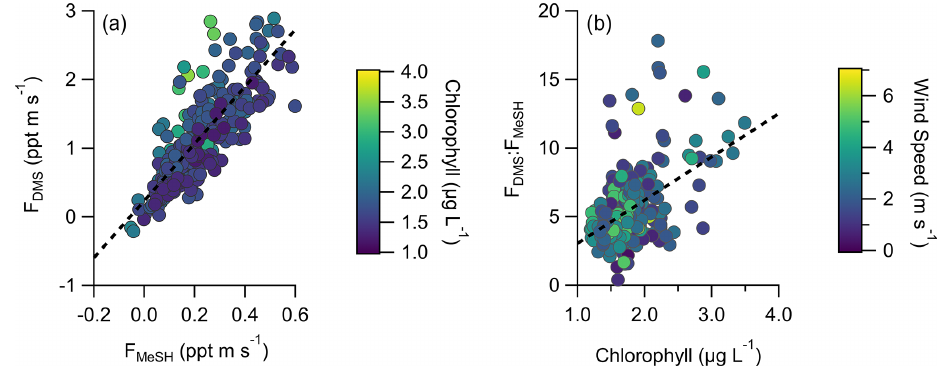
Figure 6. (a) Correlation and linear least squares regressions of measured MeSH and DMS emission fluxes ( F MeSH and F DMS , respectively). The slope of the best fit line is 4.15, and R 2 = 0 . 65. (b) Correlation and linear least squares regression of the emission flux ratio of DMS to MeSH ( F DMS : F MeSH ) with ocean chlorophyll concentrations. The slope of the best fit line is 3.15, and R 2 = 0 . 15. Points in (a) are colored by ocean chlorophyll concentrations and in (b) by mean wind speeds for each flux